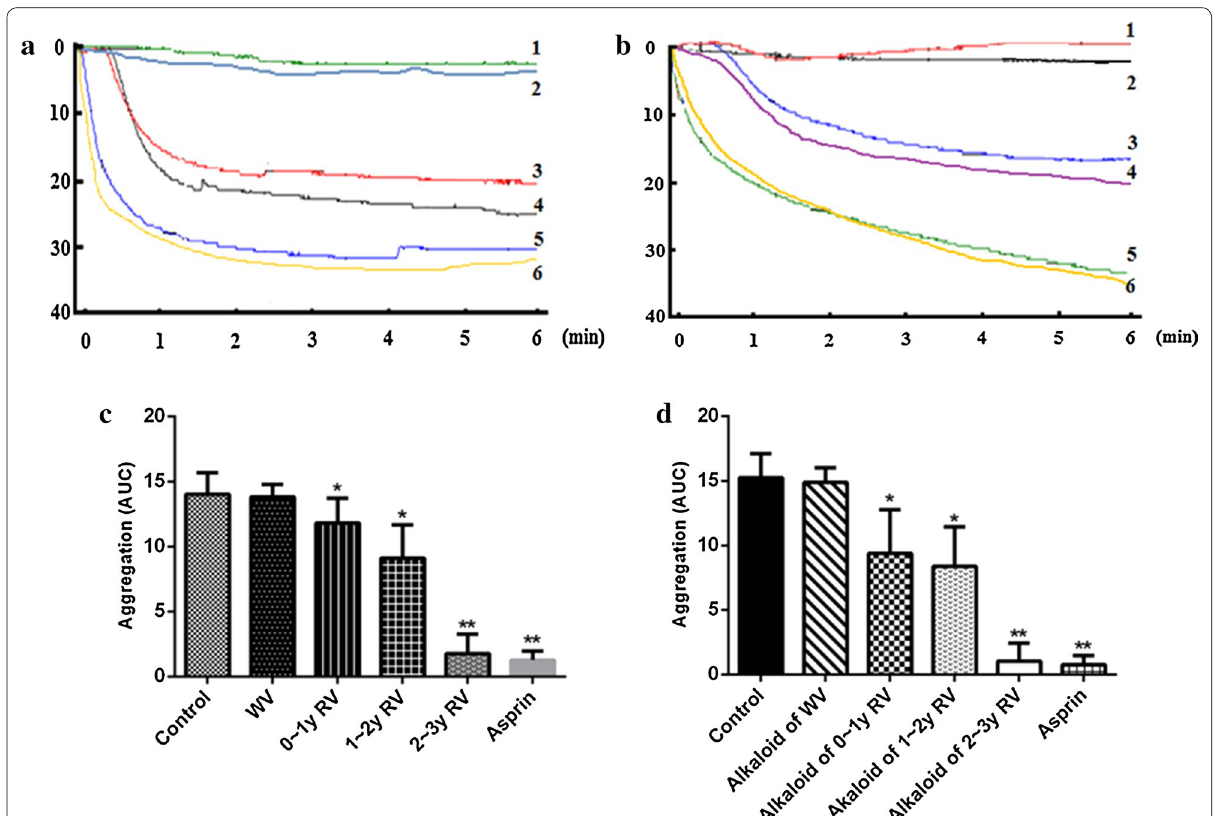
Fig. 3 a Effects of RV and WV on antiplatelet in vitro ( 1 Aspirin group; 2 2–3 year aging processed RV group; 3 1–2 year aging processed RV group; 4 0–1 year aging processed RV group; 5 WV group; 6 Control group); b alkaloids metabolites of different vinegar inhibition of AA induced platelet aggregation in vitro ( 1 Aspirin group; 2 Alkaloids metabolites of 2–3 year aging processed RV; 3 Alkaloids metabolites of 1–2 year aging processed RV; 4 Alkaloids metabolites of 0–1 year aging processed RV; 5 Alkaloids metabolites of WV; 6 Control group); c AUC value of different vinegars inhibition of ADP induced platelet aggregation in vitro; d AUC value of alkaloids metabolites of different vinegar inhibition of AA induced platelet aggregation in vitro. ‘*’ and ‘**’, p < 0.05 and p < 0.01 respectively, comparison with the normal control